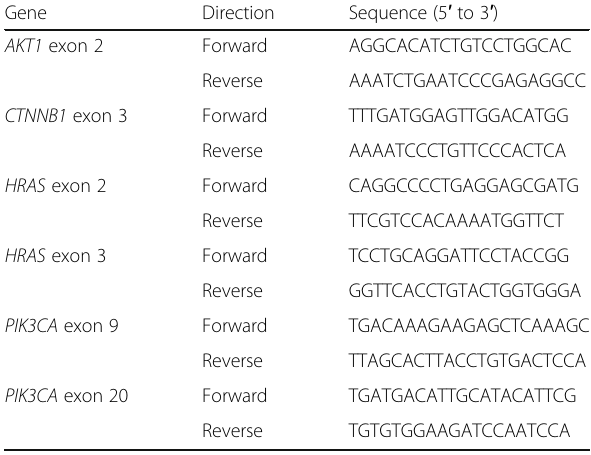
Table 1 PCR primers used for Sanger